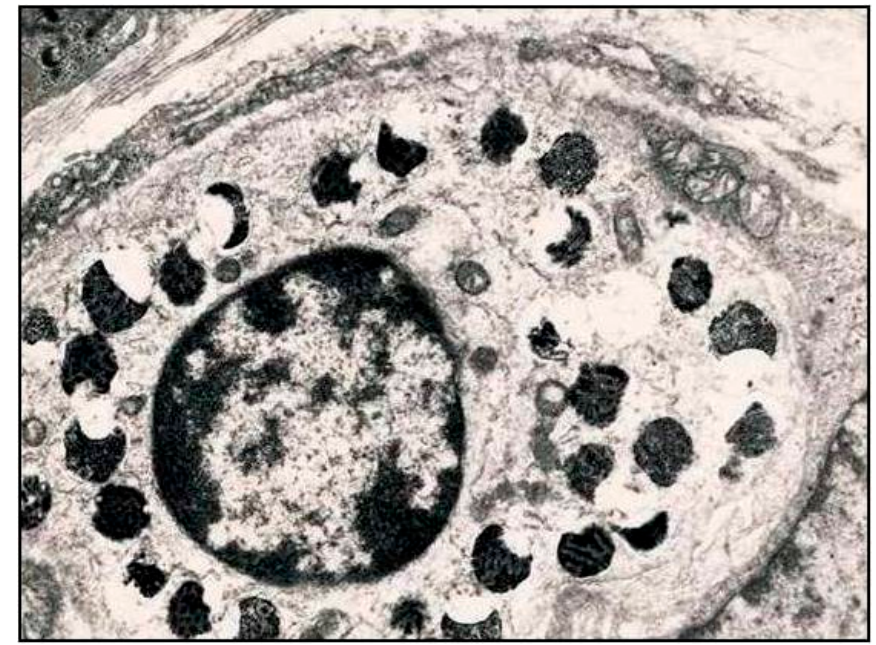
Figure 2. Intraepithelial mast cell showing partially empty, slightly enlarged, non-fused granules containers, a process similar to piecemeal degranulation; this latter phenomenon may represent a picture related to acute inflammatory reaction during H. pylori infection. (TEM, 8000×—Unpublished personal data).